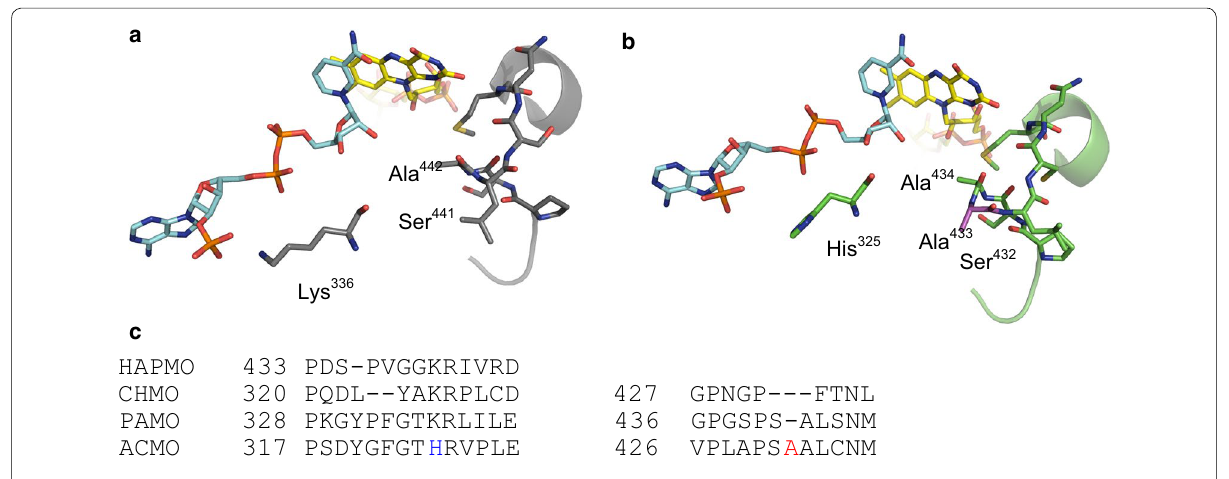
Fig. 2 Comparison of the crystal structure of PAMO ( a , PDB entry 2YLR) and a homology model of ACMO ( b ) depicting distinct residues neighboring the 2 ′ -phosphate of NADP + and the FAD and NADP + are shown as stick models with the carbon atoms in yellow and cyan, respectively. c A sequence alignment of BVMOs showing variation in the active sites. Sequence variation in ACMO is highlighted in blue and